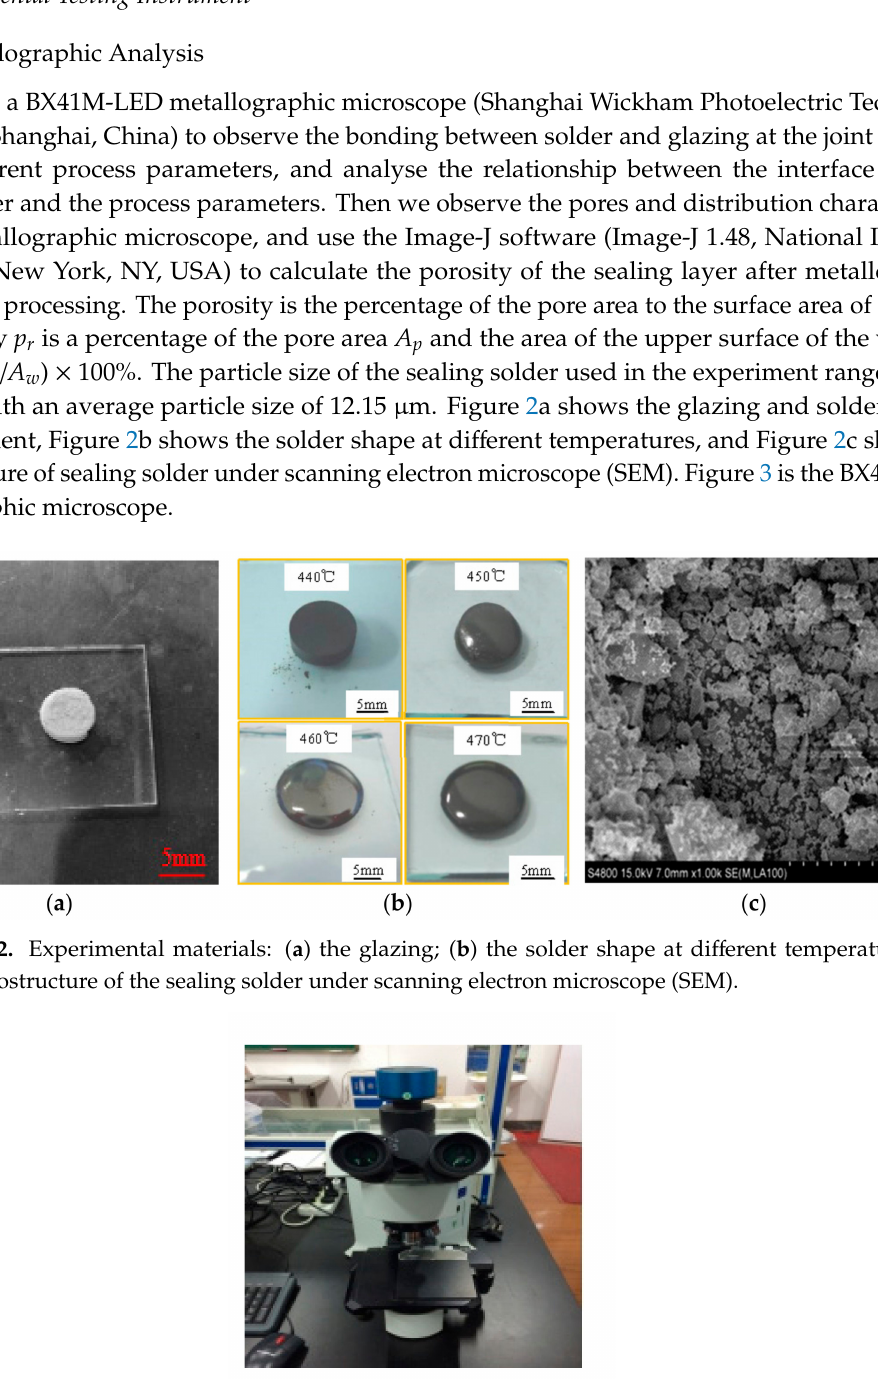
Figure 3. BX41M-LED metallographic